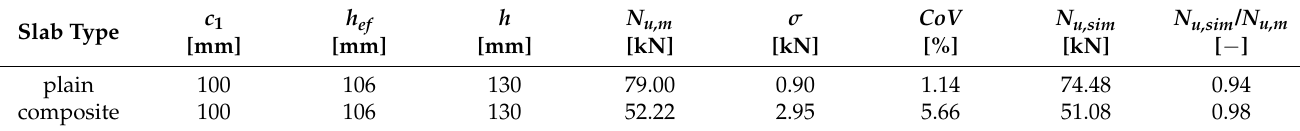
Table 3. Comparison between experimental and numerical results—4 tests were performed for each configuration. Slab